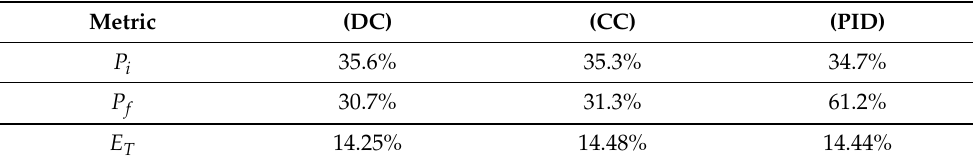
Figure 8. Centralized framework simulated via Algorithm 3, (N = 50). Table 1. Simulation